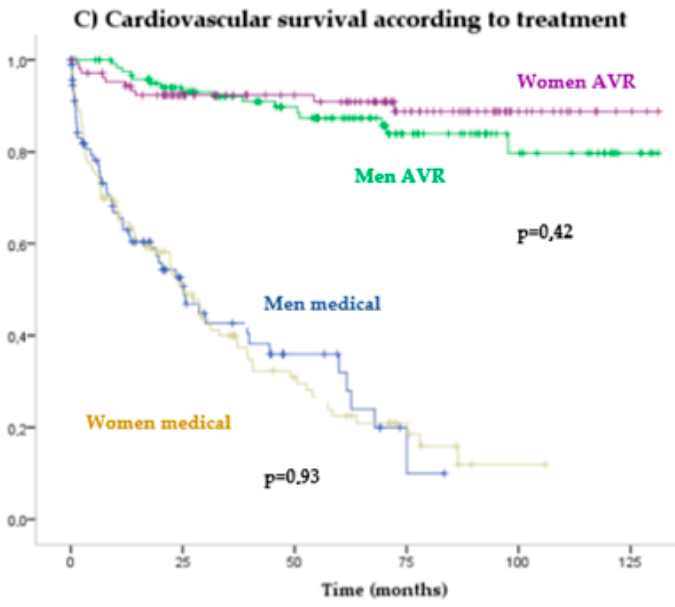
Figure 3. Kaplan–Meier survival curves according to gender.